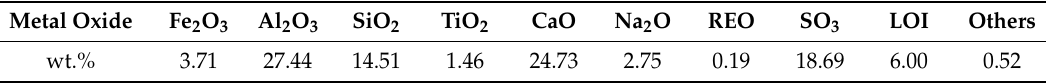
Table 3. Chemical analysis of the residue after leaching BR at optimum conditions.